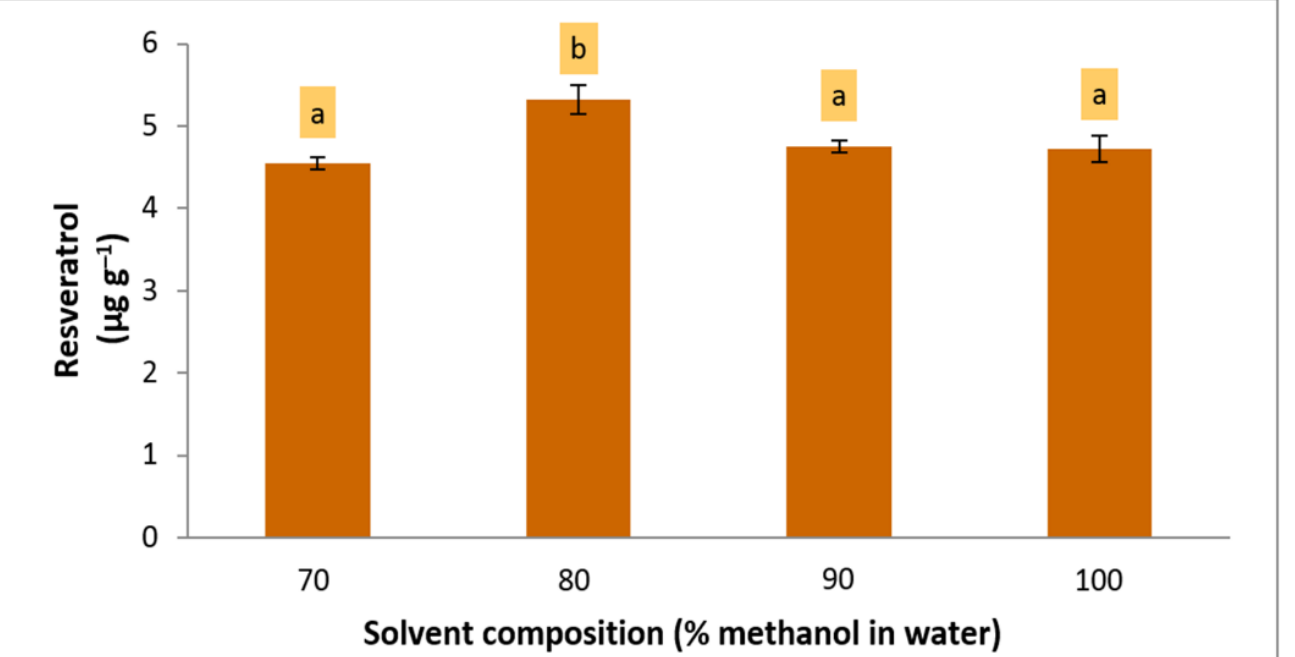
Figure 3. Further optimization for solvent composition in the extraction of resveratrol from cookie samples. Different letters in the bars mean significant differences (95% confidence level).